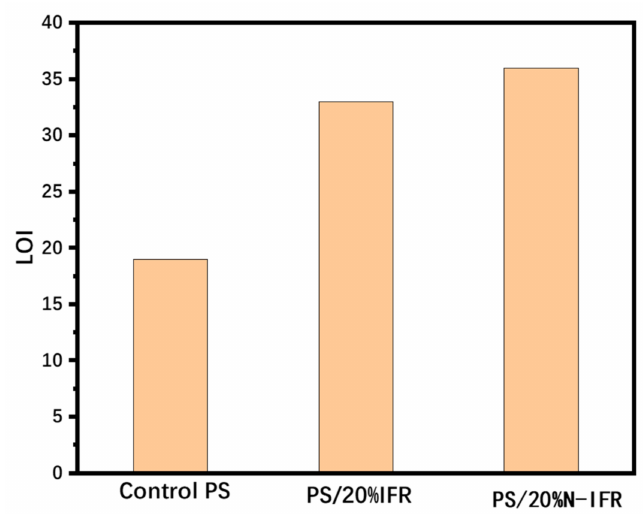
Figure 3. The LOI of control PS, PS/20%IFR, and